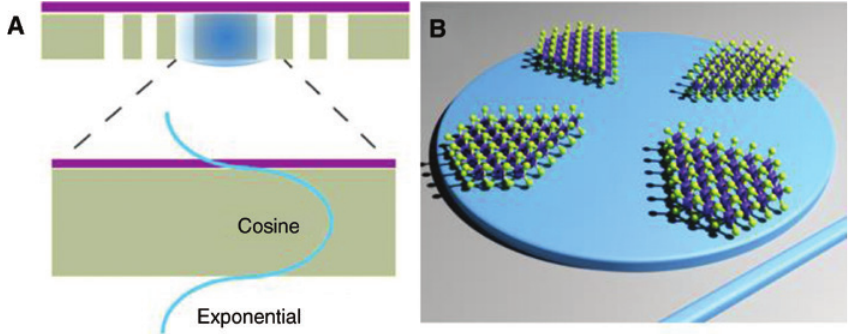
Figure 2: Modeling of nonlinear layered material integrated optical resonator. (A) The theoretical model to estimate the effective nonlinearity for a layered material placed on top of the cavity assumes the cavity mode follows a cosine function inside the slab, and decays exponentially outside the slab. (B) Schematic of a disk with patterned layered mate- rial on top: by intelligently patterning the material on top, the mode profiles are not significantly altered, but the nonlinear overlap can be significantly